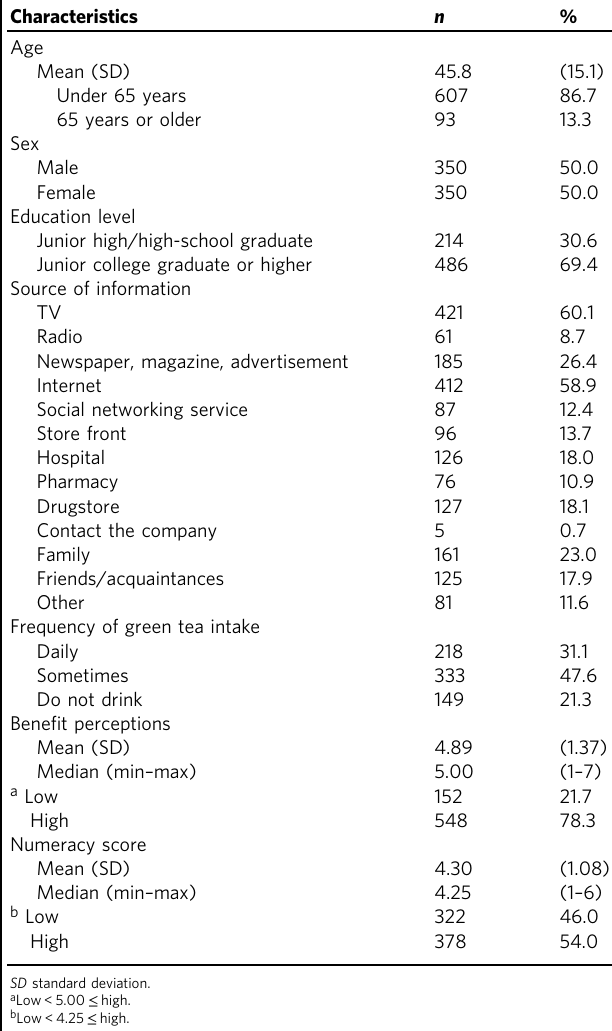
Table 1 Characteristics of the study sample ( N =